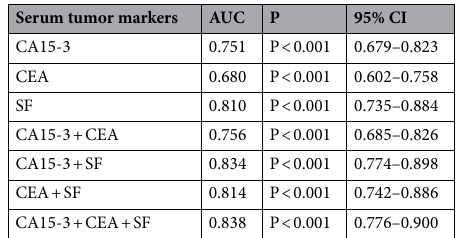
Table 5. The area under ROC curve of CEA, CA15-3 and SF in the diagnosis of Canine mammary gland tumor.